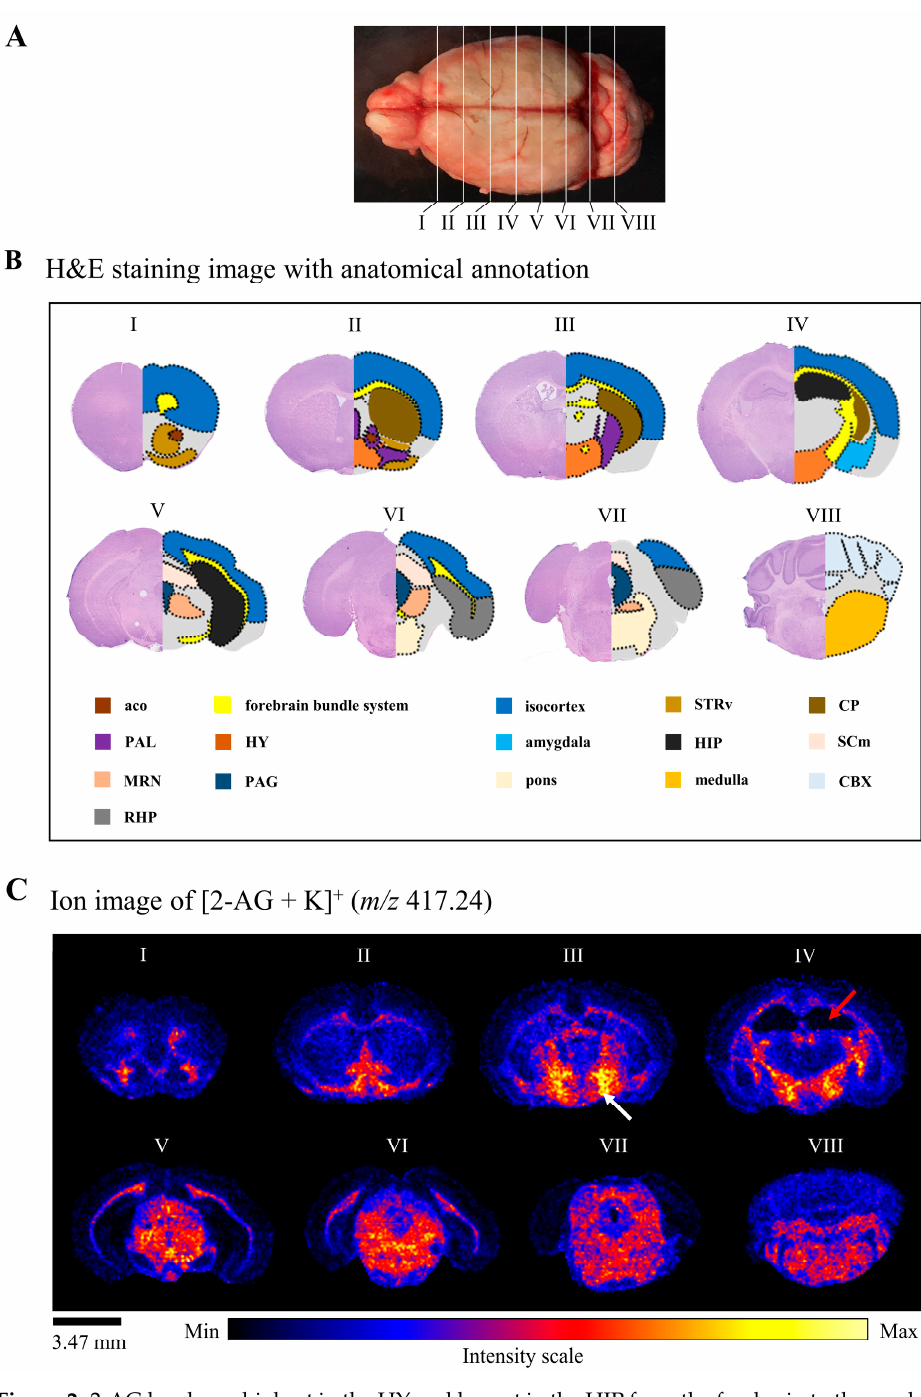
Figure 2. 2-AG levels are highest in the HY and lowest in the HIP from the forebrain to the cerebellum. ( A ) Schematic of the location of the sections (from I to VIII) from the forebrain to the cerebellum. The interval between each section is approximately 1200 µm. ( B ) H&E images (I to VIII) with anatomical annotation, following Allen Brain Atlas (https://atlas.brain-map.org/, accessed on 1 November 2022). ( C ) Ion images of 2-AG distribution in corresponding coronal brain sections (I to VIII). The 2-AG signal intensity of the corresponding area is displayed according to the rainbow colors. The white and red arrows indicate the highest and lowest 2-AG levels, respectively (scale bar: 3.47 mm). aco: anterior commissure, olfactory limb, STRv: striatum ventral region, CP: caudate putamen, PAL: pallidum, HY: hypothalamus, HIP: hippocampal region, SCm: superior colliculus, motor-related, MRN: midbrain reticular nucleus, PAG: periaqueductal gray, CBX: cerebellar cortex, RHP: retrohippocampal region.